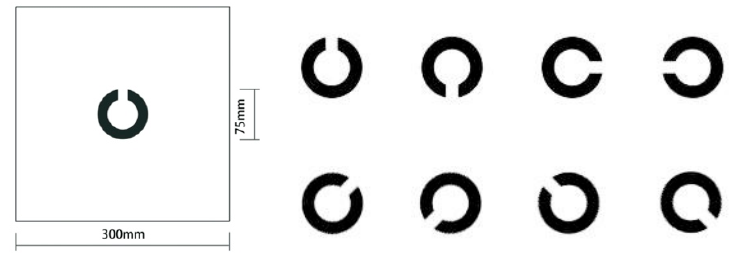
Figure 1. Visual target—landolt c.